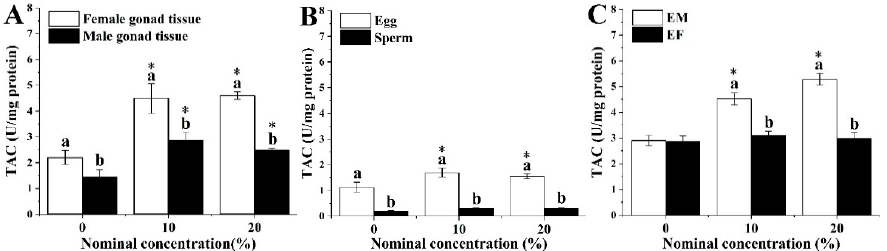
Figure 3. Levels of total antioxidant capacity (TAC) in ( A ) gonad tissues, ( B ) gametes ( C ) and larvae derived from different parental exposed behaviors with HFO WAFs for seven days. Data are presented as means ± SD. Lowercase letters indicate significant differences between sexes. An asterisk (*) labeled above bars indicates significant differences between treatments and the control ( p < 0.05).